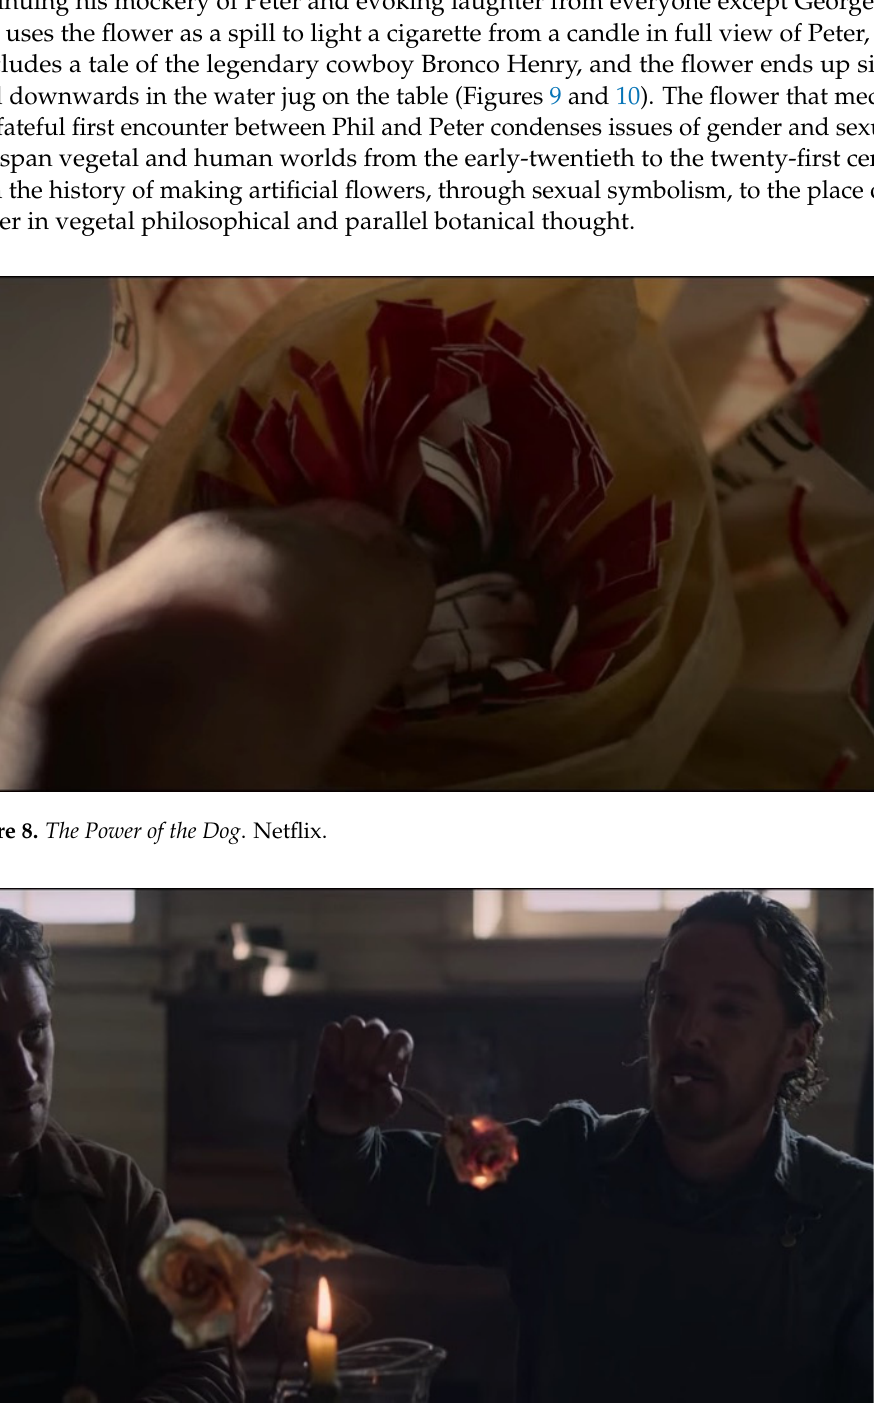
Figure 10. The Power of the Dog . Netflix. By the time of the setting of Savage’s novel in 1925, an Artificial Flower Industry was booming in the US, which included the preservation of natural flowers and plants along- side the manufacture of artificial flowers from paper and cloth 2 [21] . The making of paper flowers was also a means of generating income from home or just a popular leisure pur- suit across America (and Europe) in the nineteenth and early-twentieth centuries. Jim Jar- musch’s Western Dead Man (1995), set in the late nineteenth century, touches on this when William Blake (Johnny Depp) meets Thel Russell (Mili Avital), a former prostitute who makes and sells paper roses 3 . Paper has long been a popular substance in artificial flower making, which many writers of manuals on this craft put down not only to its malleability and suitability to the qualities of the flower, with crepe and tissue paper most favored, but also its economical price for both industrial fabrication and for the hobbyist [22] (p. 5) [23] (p. 6). Flower-making manuals were initially written by women and addressed to many different constituencies of women and girls [15,24–27] 4 . From the mid-twentieth century onwards, the addressees of these texts expanded, with Rosemary Brinley declar- ing artificial flower making in 1952 to be “a complete and satisfying craft for workers of all ages and both sexes” [28] (unpaginated e-book, loc. 1100–1109), and with more diverse expert crafters writing such manuals today [29]. Ahead of his time, Peter was engaged in